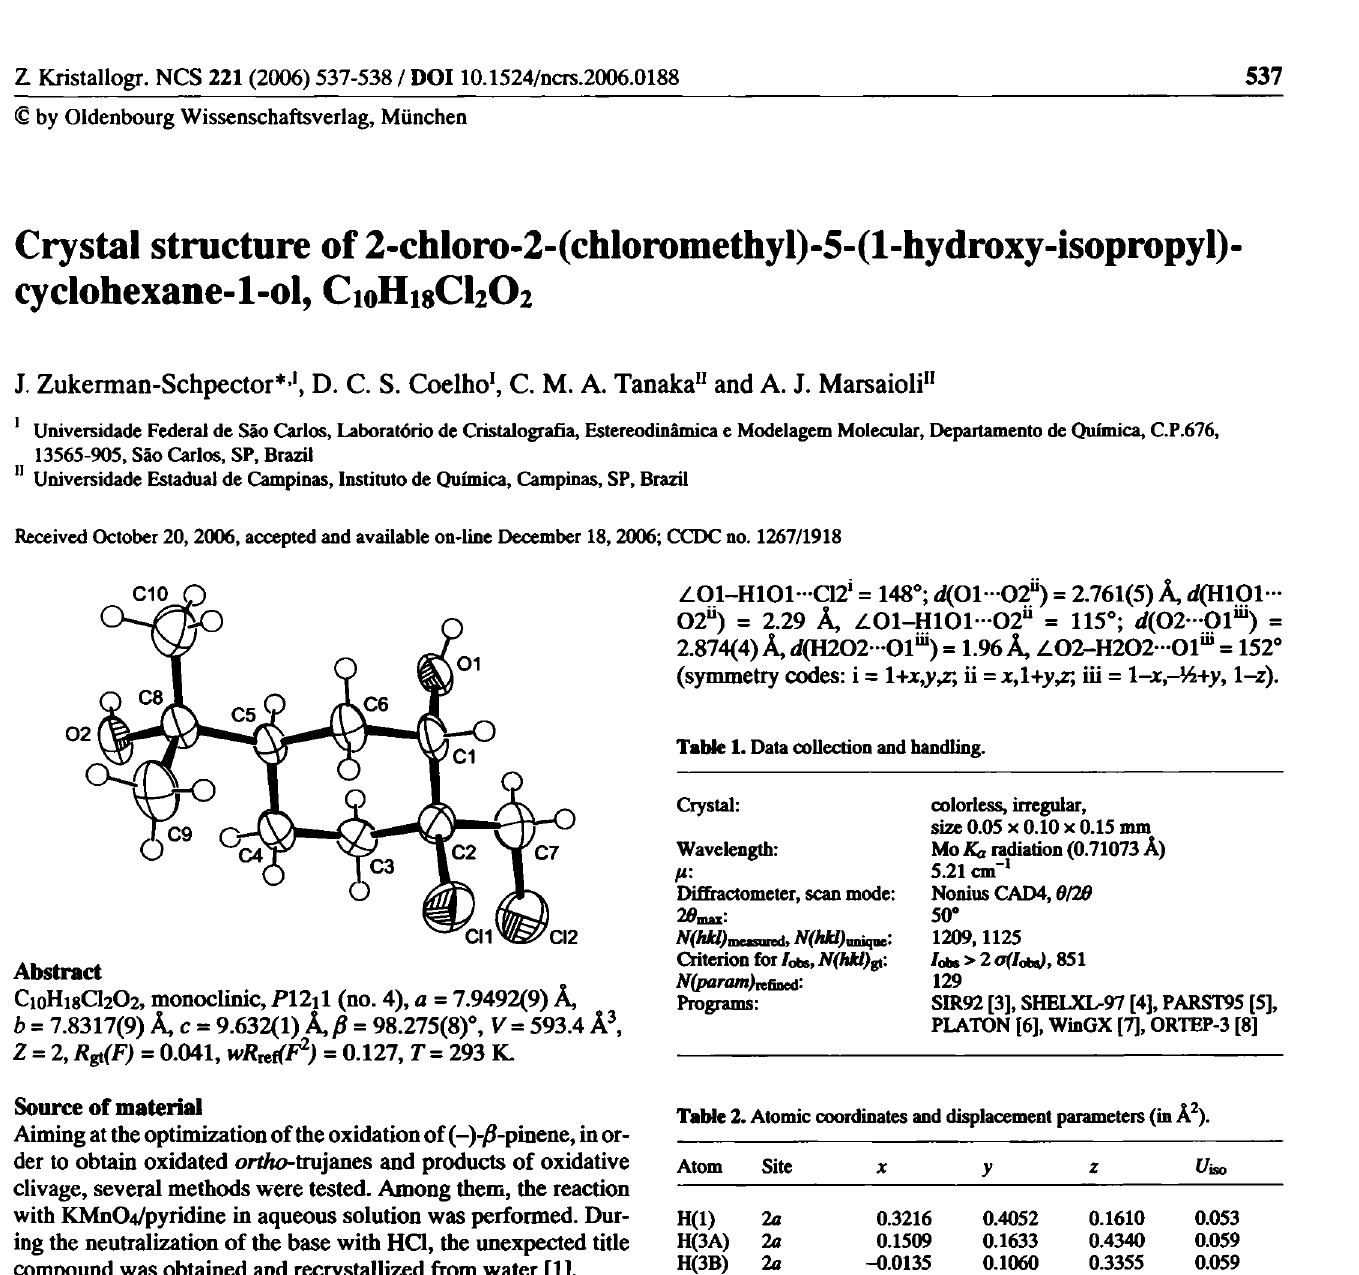
Table 2. Atomic coordinates and displacement parameteis (in Ä 2 ).